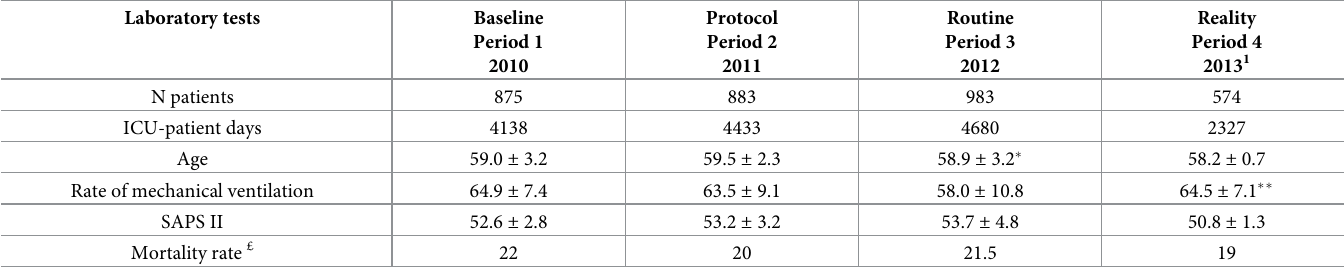
Table 3. Demographic characteristics according to different